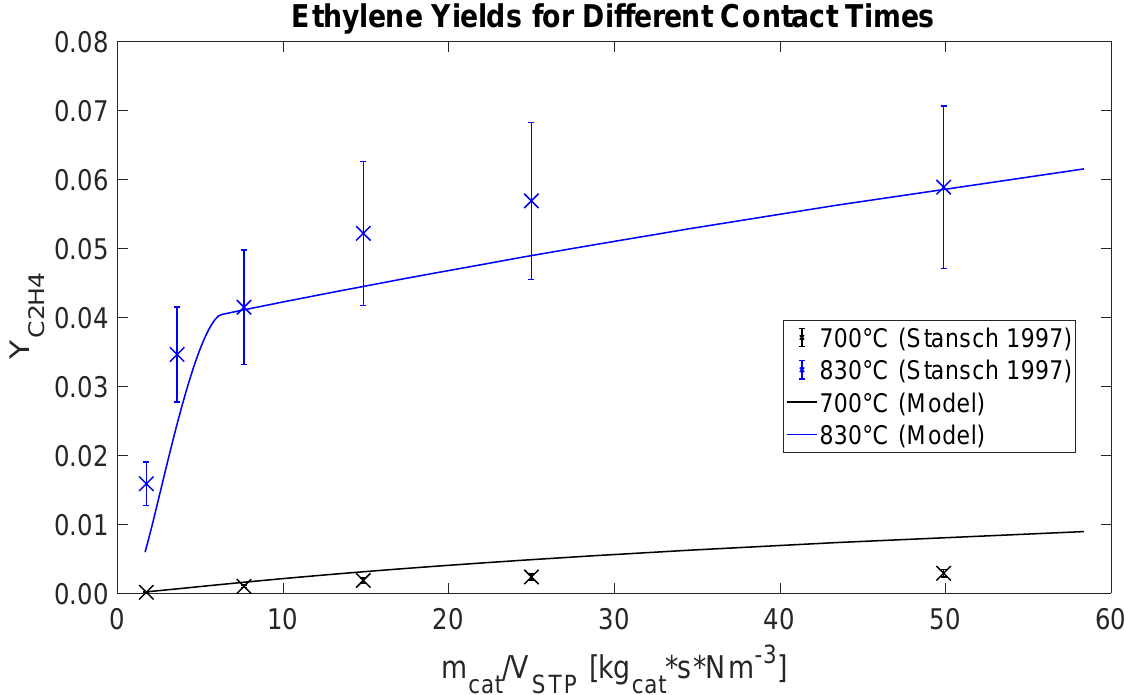
Figure 2. Product (C 2 H 4 ) yield for different contact times obtained with an OCM-PBR operated isothermally at 700°C and 830°C. Reactor model predictions compared to experimental data from [7]. Reproduced with permission from Penteado, Ph.D. Thesis, TUB, 2021